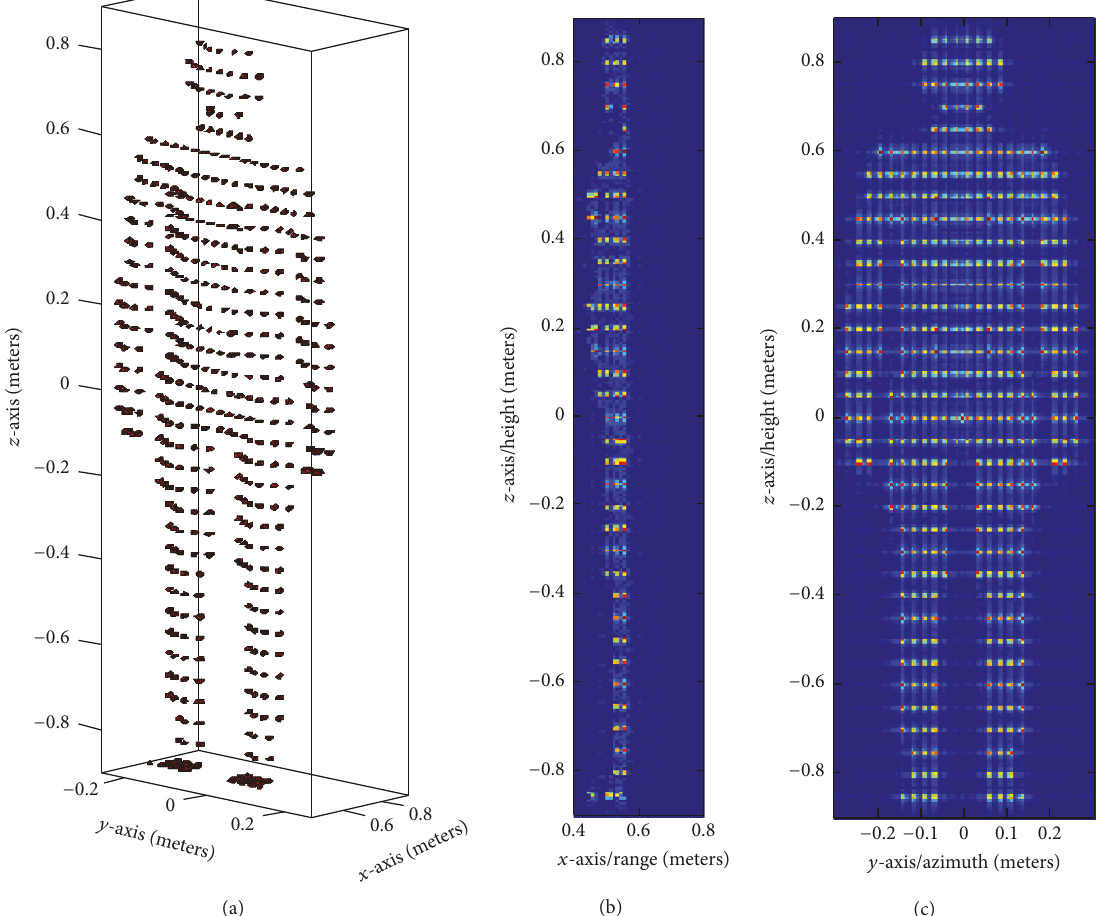
Figure 4: (a) Isosurfaces ( − 3dB) of the 3D reconstructed image processed by the proposed algorithm; maximum values projections of (b) side view and (c) front view.